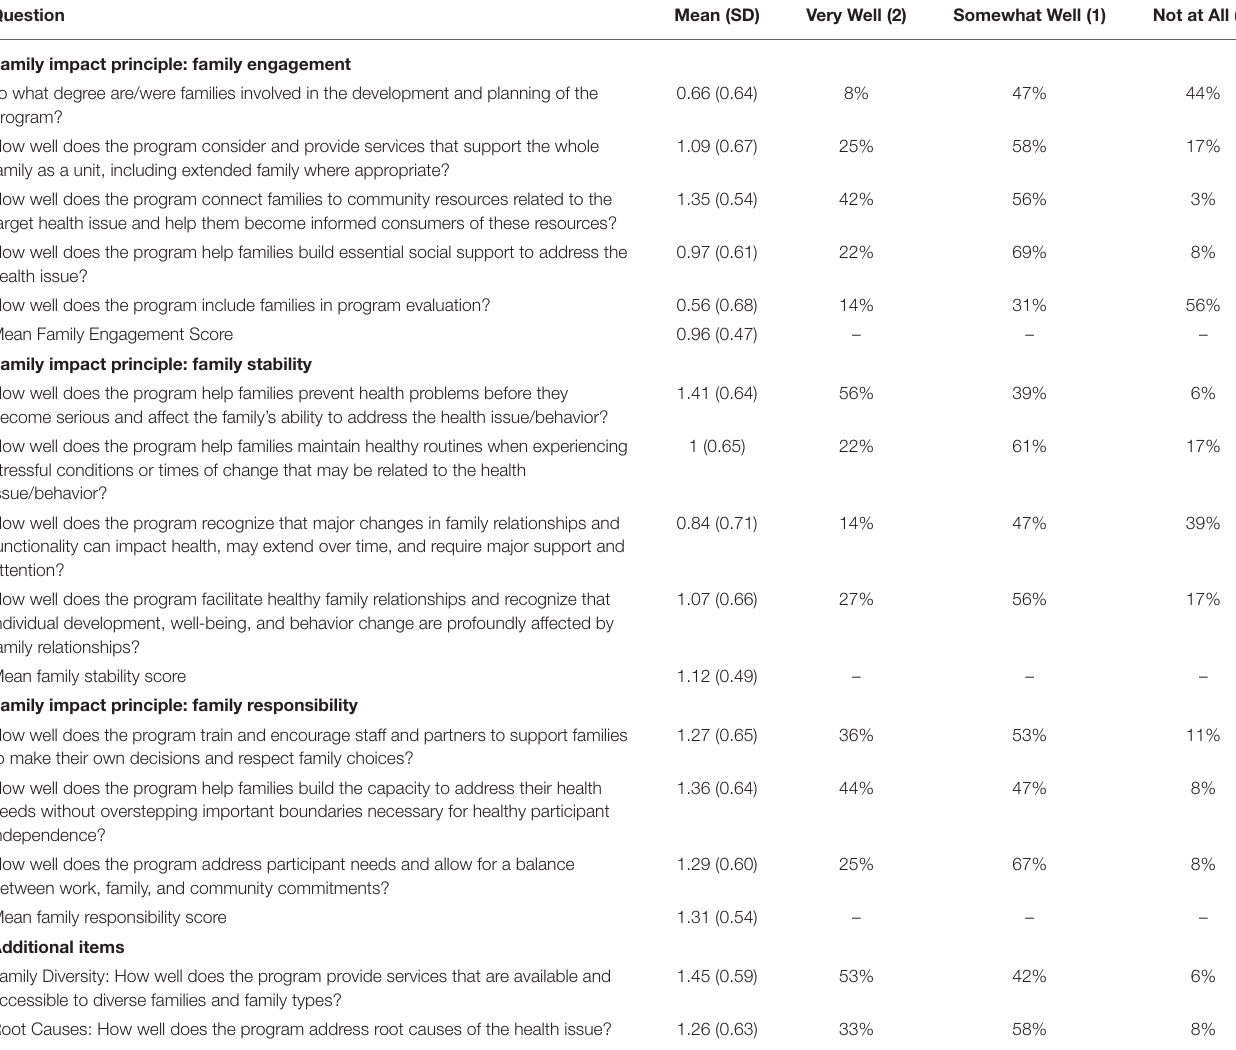
TABLE 1 | Summary of family impact principle results.